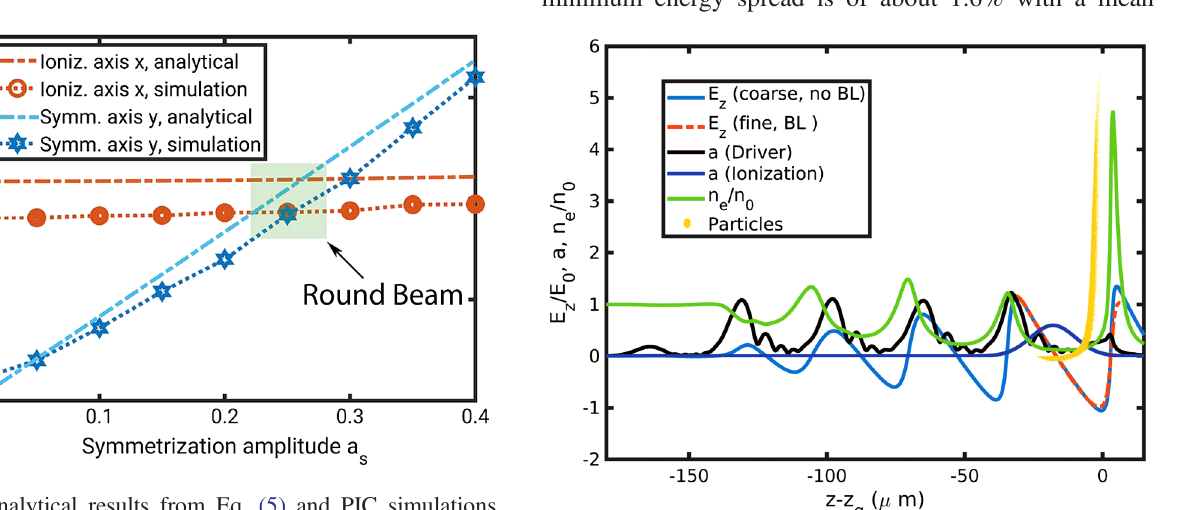
FIG. 4. Analytical results from Eq. (5) and PIC simulations obtained with FB-PIC of the electron beam emittances along the x (ionization pules polarization) and y (symmetrizing pulse) polarization axes. The ionization pulse has normalized amplitude ¼ 0 . 63 , N ¼ 3 (third harmonics), and is focused with a a i ¼ 3 μ m. The ionization and symmetriza- minimum waist w 0 ; ion tion pulses have FWHM duration of 30 fs. Both the analytical and simulated curves show that a (quasi) round beam can be obtained, ≃ 0 . 25 . in this configuration, with a s